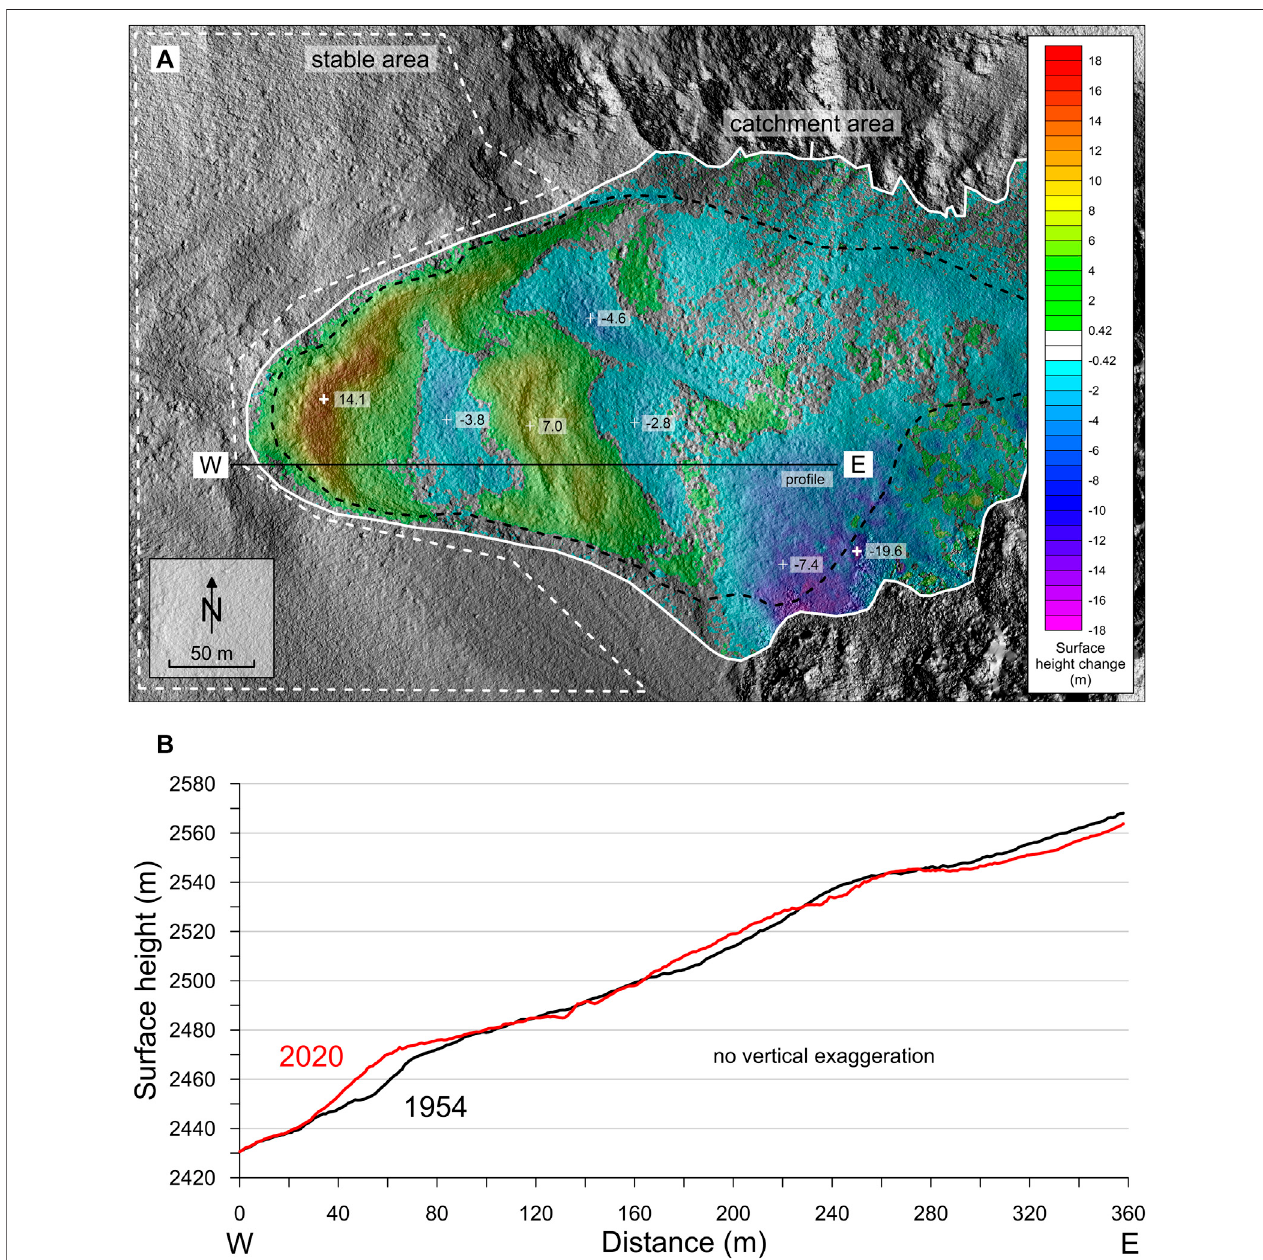
FIGURE 5 | (A) Color-coded surface height change for the time period 1954 – 2018. The signi fi cance level is at ± 0.42 m (standard deviation, 1- σ rule). Single spot height differences (max. 14.1 m, min. − 19.6 m) are shown. (B) Longitudinal pro fi le W-E for the time period 1954 – 2020.